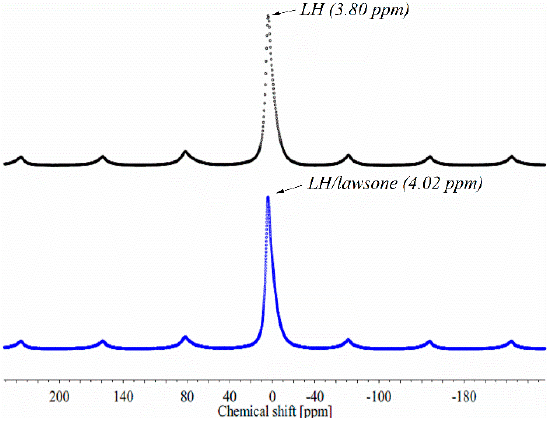
Figure 3. 27 Al MAS NMR spectra of the LH and LH/lawsone pigments.